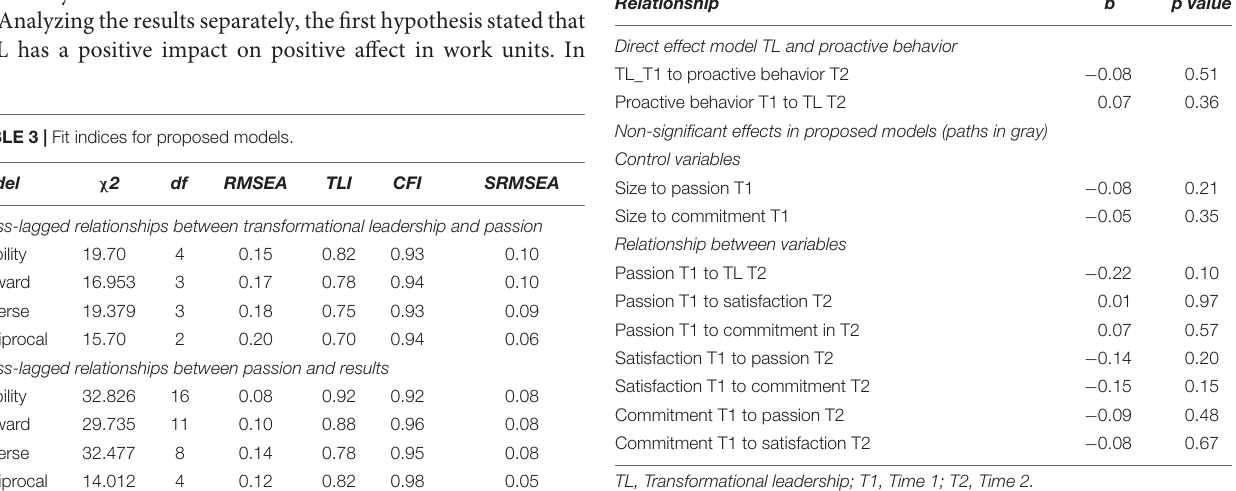
partially supported as the relationship of TLF and proactive